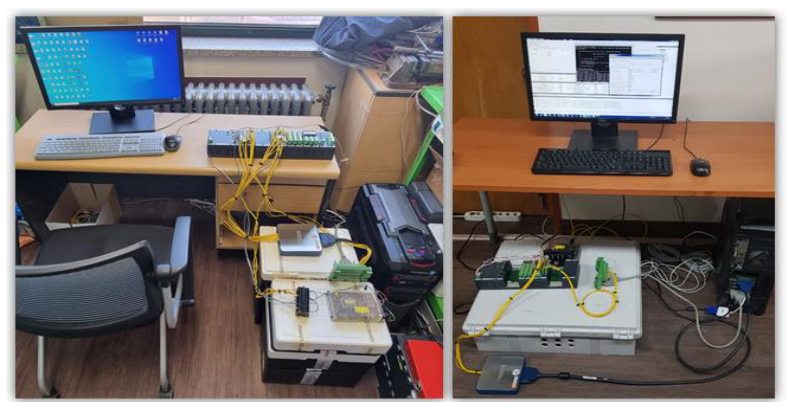
Figure 6. HILS environment on LAB scale.